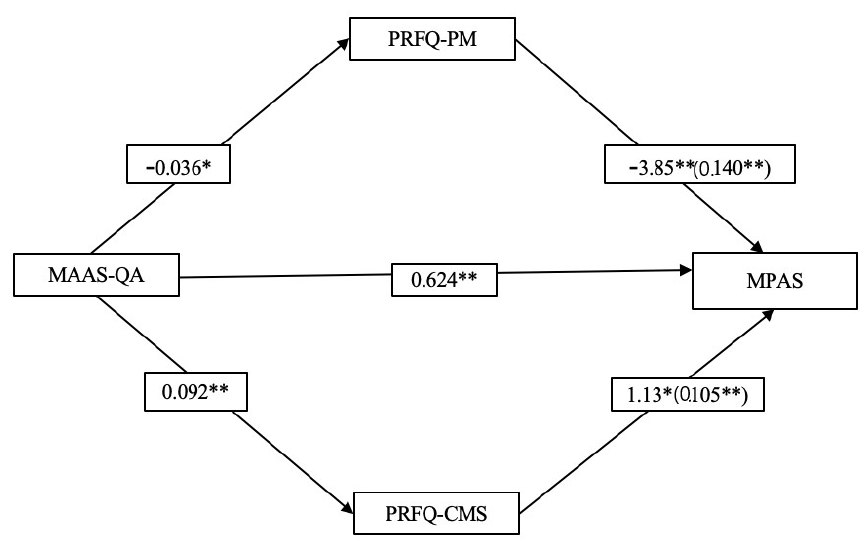
Figure 2. Mediation analysis testing the direct and indirect effects of MAAS-QA on MPAS mediated by PRFQ subscales. * p < 0.05, ** p < 0.01.